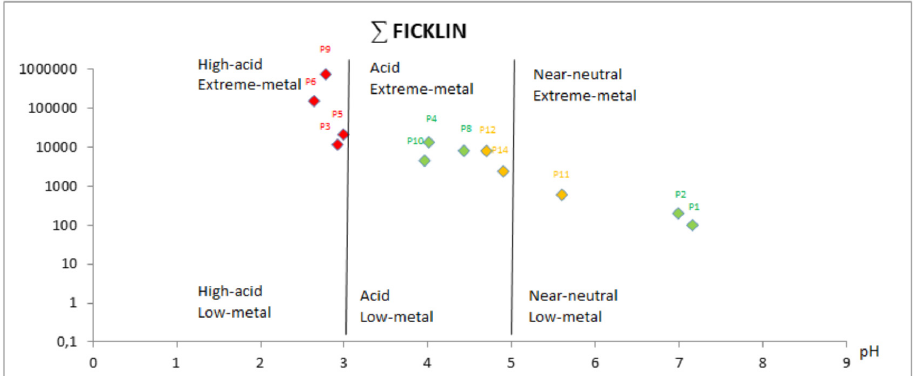
Figure 4. Ficklin diagram showing the sampling points’ grouping, accordingly to water type. When studying the Odiel River sampling points in a strict sense (green colour), points 1 and 2 had very low metal concentrations and a neutral pH, as they are unaffected by AMD. Along the Odiel watercourse, as soon as we started to go down to the sea, the river receives more AMD contaminated effluents, which is why points 4, 8 and 10 have more acidic pH and higher metal concentrations. Points 7, 13 and 15 were not represented in the diagram as they were unaffected by AMD and do not contain any of the Ficklin’s metals.